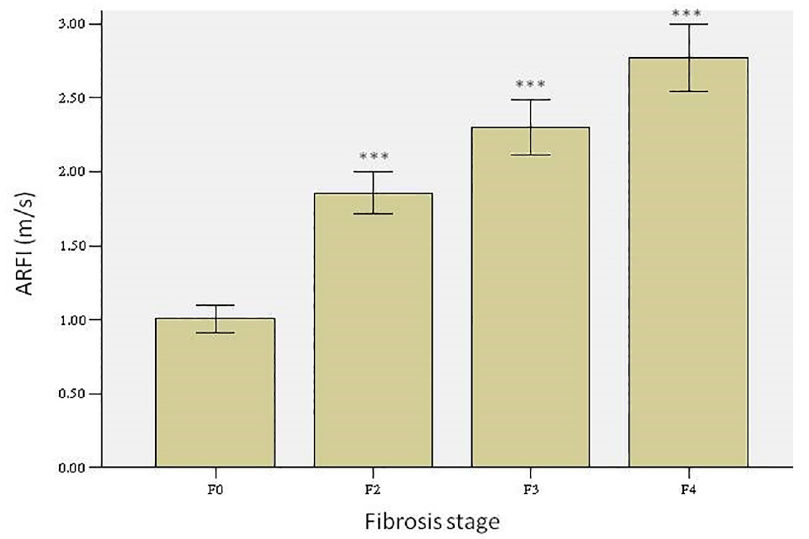
Fig 5. Comparison of the elasticity values of different fibrosis